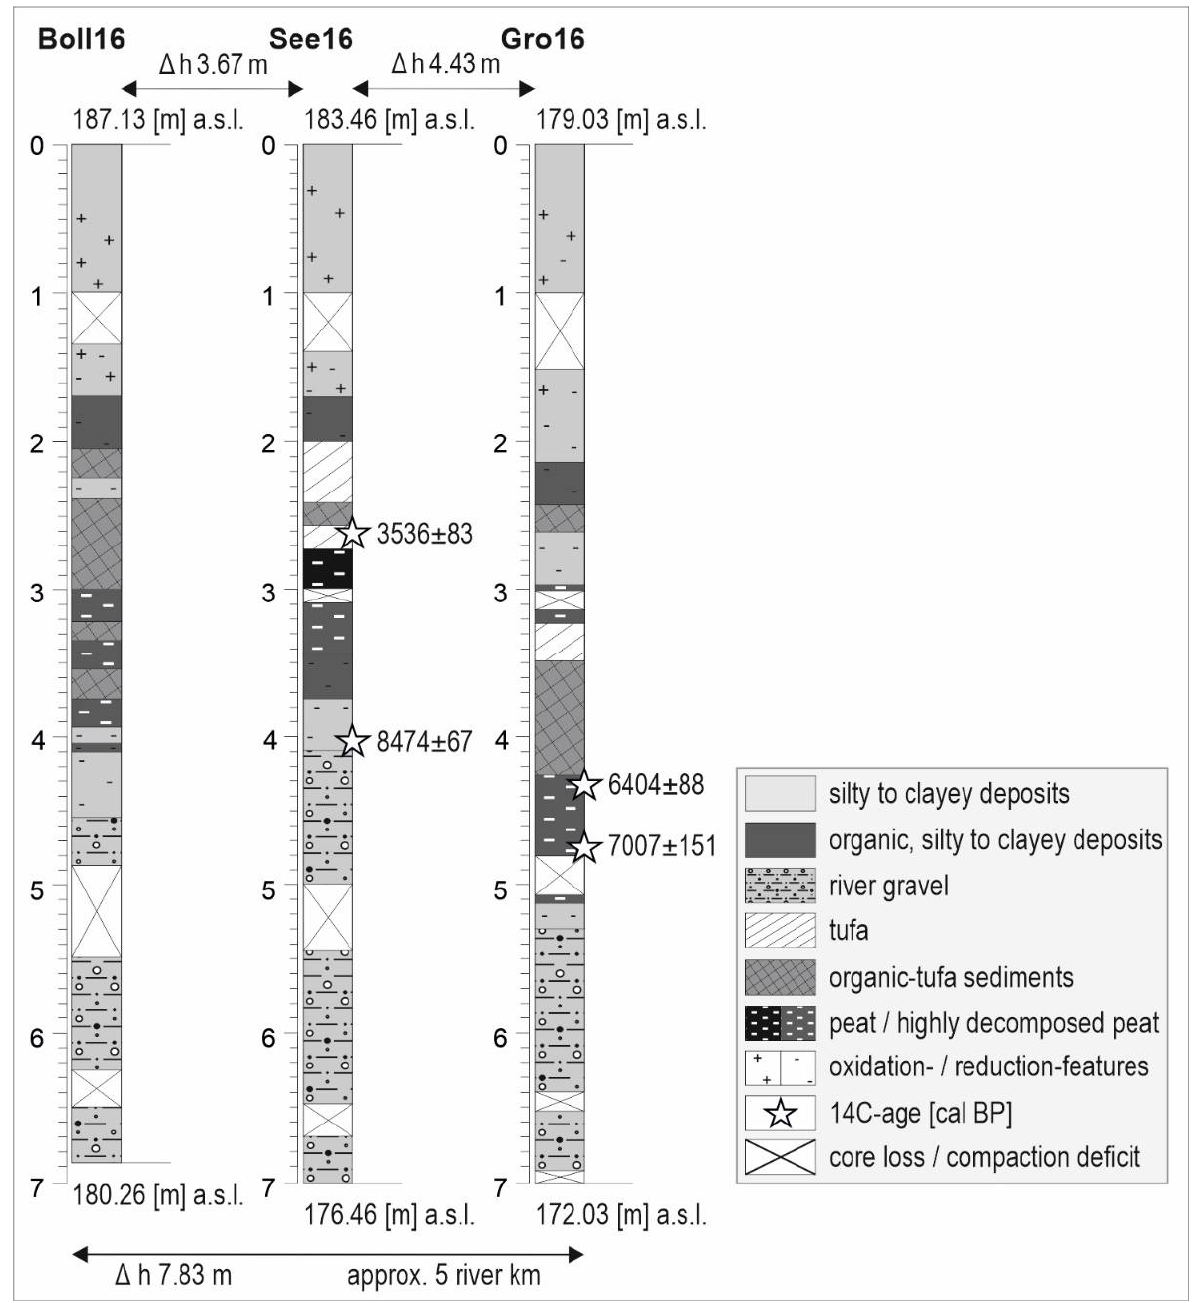
Figure 5. Drilling results from initial drillings Boll16, See16, and Gro16 (Figure 1C). Predominantly Silty Sediments (Interpreted as Loess and Loess